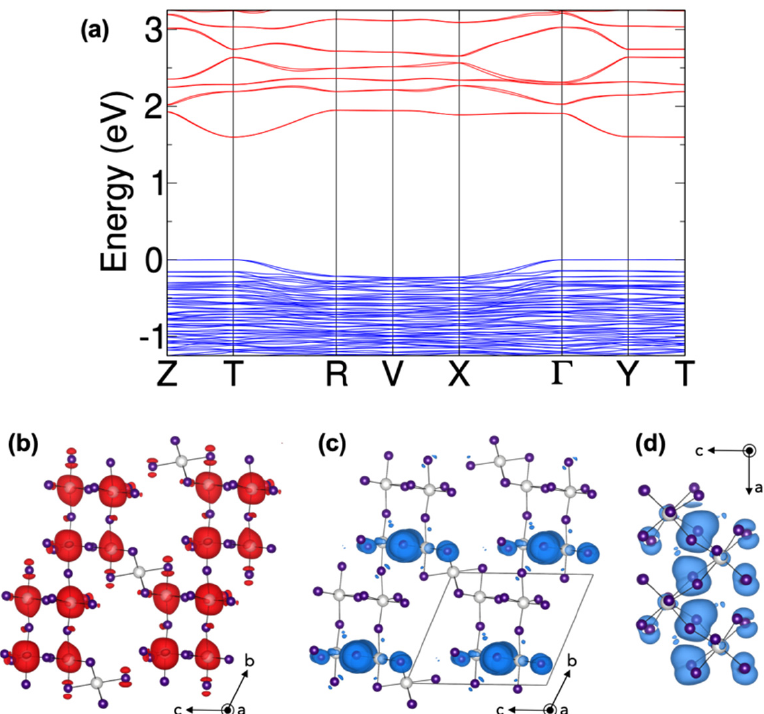
Figure 4. ( a ) Computed band structure (blues lines: valence band, red lines: conduction band) of (HPA) 6 (MA)Pb 5 I 17 . The system presents a direct band gap at T with E G = 1.60 eV. ( b , c ) Partial charge densities computed at the conduction band minimum and the valence band maximum, respectively. ( d ) Same as ( c ) from a different viewpoint. Organic cations are not depicted for clarity (purple atoms: I, white atoms: Pb).